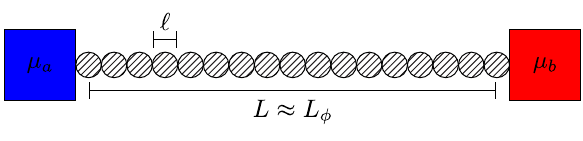
FIG. 1. Schematic representation of a mesoscopic system coupled to two reservoirs of different chemical potentials μ and μ . Here, l denotes the ballistic length, above which the b transport is diffusive, and L ϕ is the coherence length, below which interference effects can be